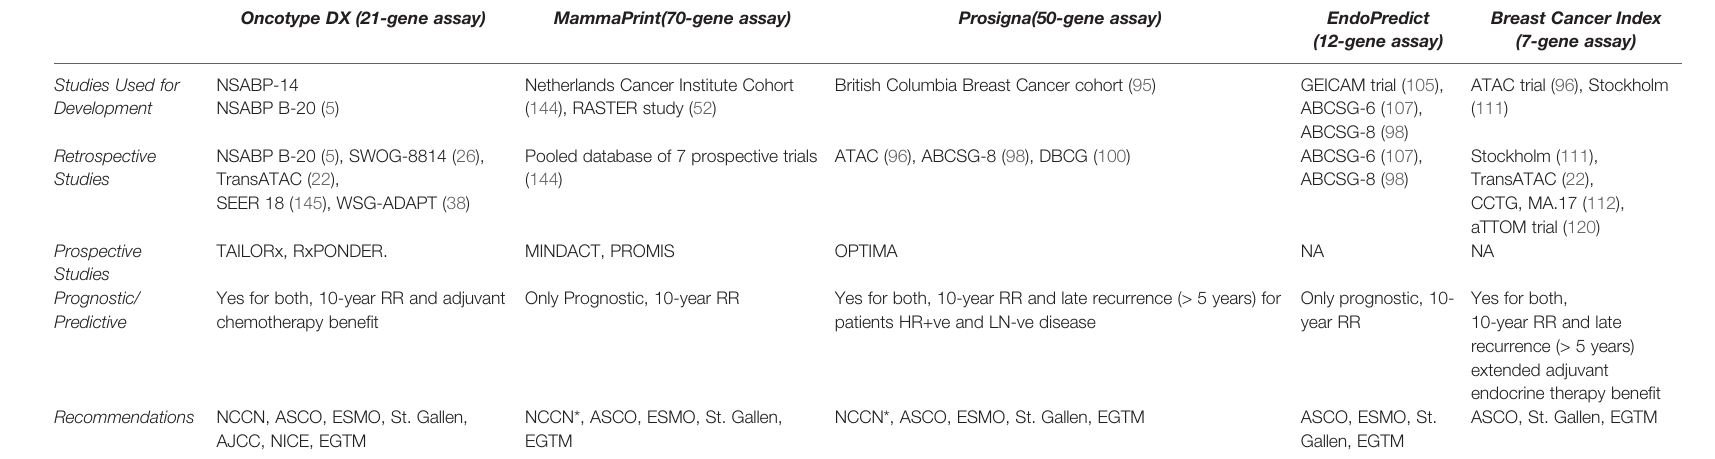
TABLE 2 | ASCO, American Society of Clinical Oncology; EGTM, European Group on Tumor Markers; ER+, Estrogen-receptor-positive; ESMO, European Society for Medical Oncology; NCCN, National Comprehensive Cancer Network; DBCG, Danish Breast Cancer Group; CCTG, Canadian Cancer Trials